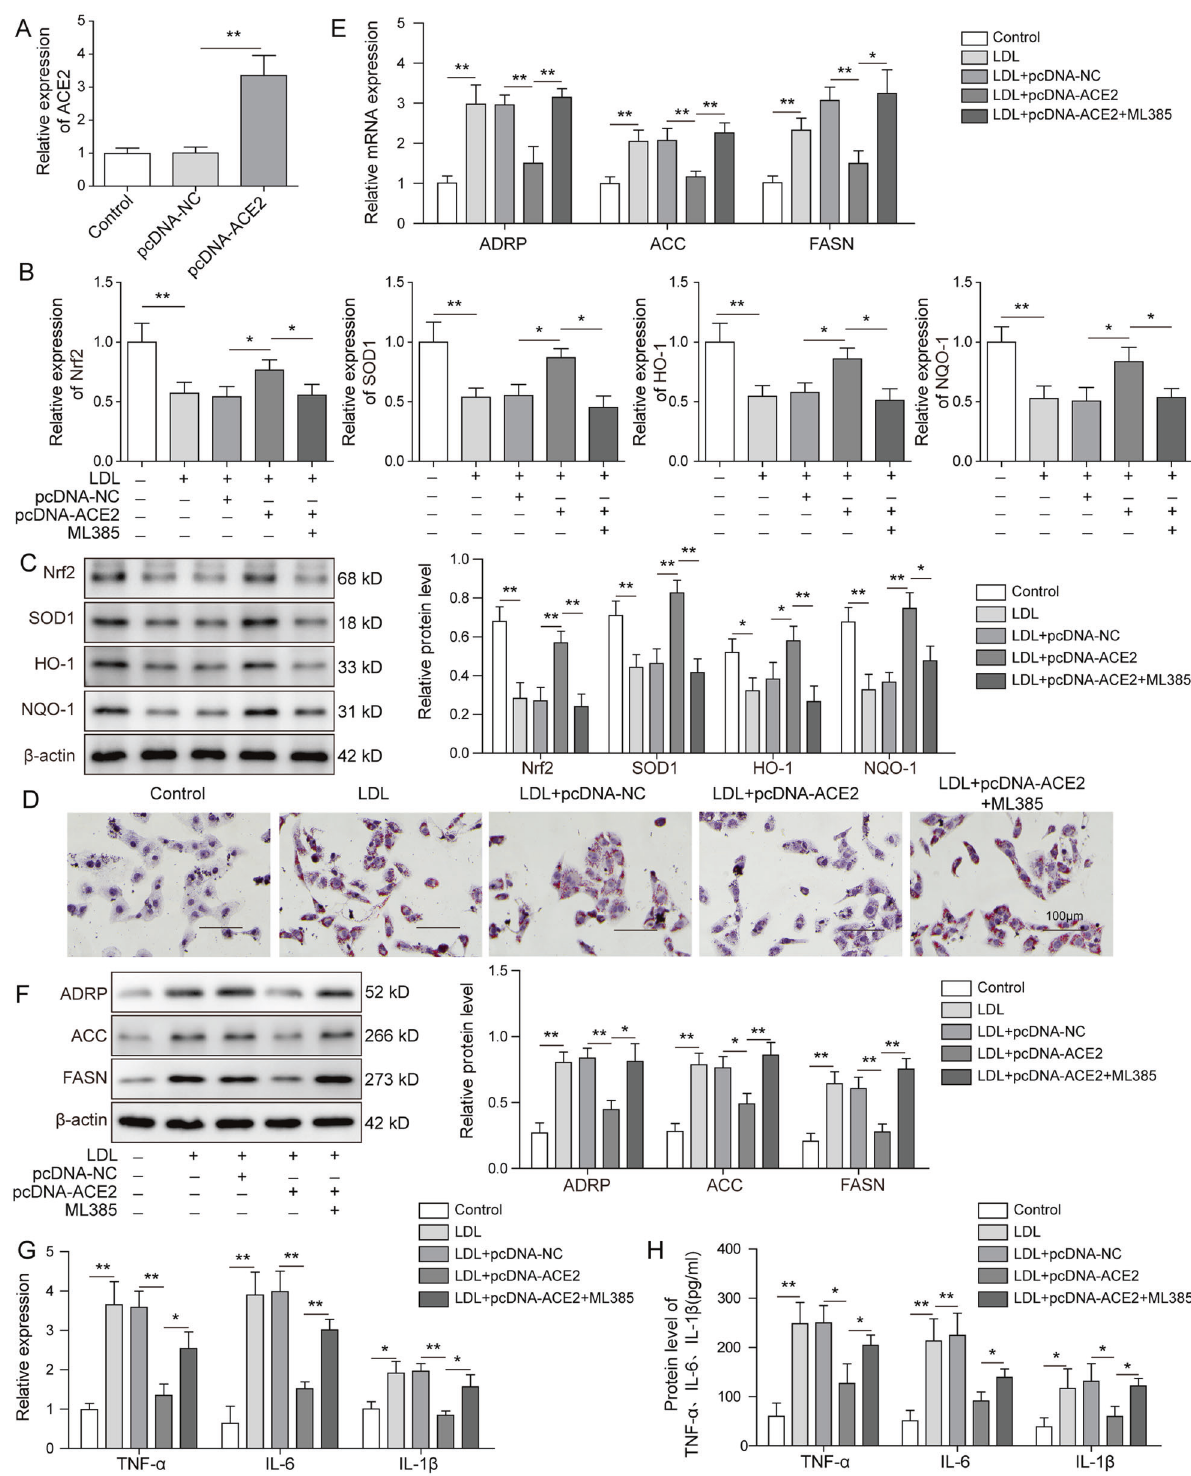
Fig. 5 ACE2 attenuated lipid deposition and in fl ammatory responses by acting through Nrf2 pathway. Primary mouse renal PTCs were treated with ox-LDL and transfected with pcDNA-ACE2 for stable expression. A Transfection ef fi ciency was calculated by qRT-PCR detection of the ACE2 mRNA expression. B , C qRT-PCR and western blot analysis were performed to measure the protein expression of Nrf2 signaling pathway elements including Nrf2, SOD1, HO-1, and NQO-1. ACE2 overexpression reactivated Nrf2 pathway, which was inhibited by ox-LDL, and the Nrf2-inhibitor ML385 abrogated the effect above. D Cellular lipid droplet formation was visualized by Oil Red O staining. Cellular lipid synthesis was evaluated by examining the expression of ADRP, ACC, and FASN at mRNA ( E ) and protein levels ( F ). Expression pro fi les of the in fl ammatory cytokines were determined at mRNA ( G ) and protein ( H ) levels. ACE-2 overexpression diminished expression of TNF- α , IL-6, and IL-1 β , which was rescued by ML385. Data were representative images or were expressed as the mean ± SD of n = 3 experiments. * P < 0.05, ** P <